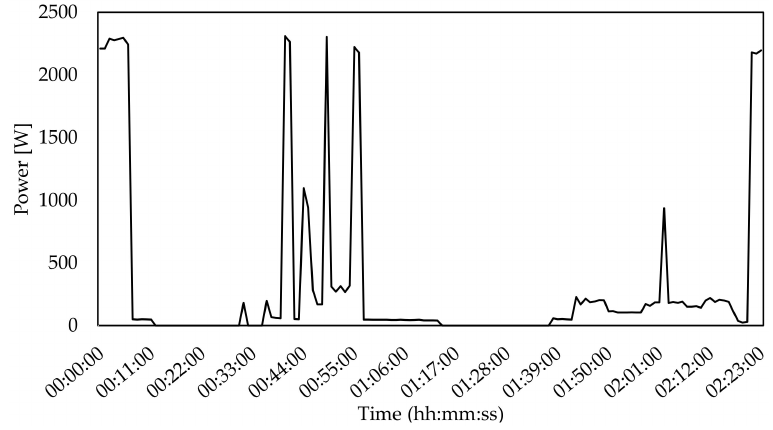
Figure 6. Example of power demand of a house with sampling equal to 10